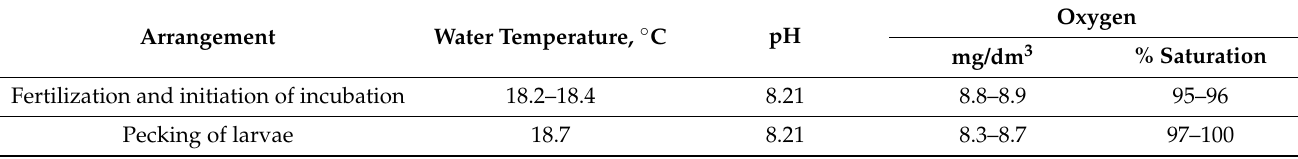
Table 7. Abiotic parameters during incubation of Balkhash marinka eggs in industrial conditions. Arrangement Water Temperature, ◦ C Fertilization and initiation of incubation Pecking of